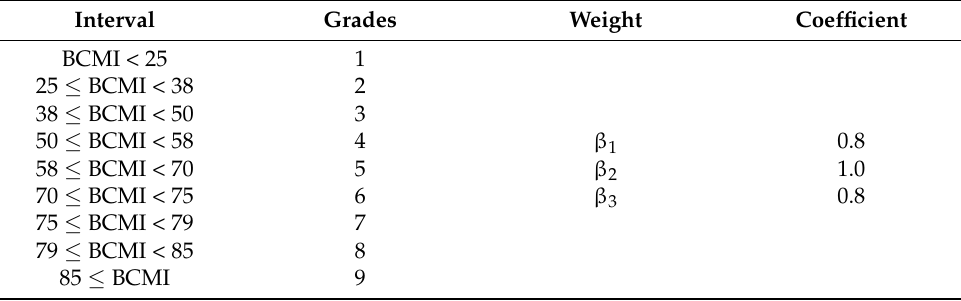
Table 2. Levels of body comfort meteorology index